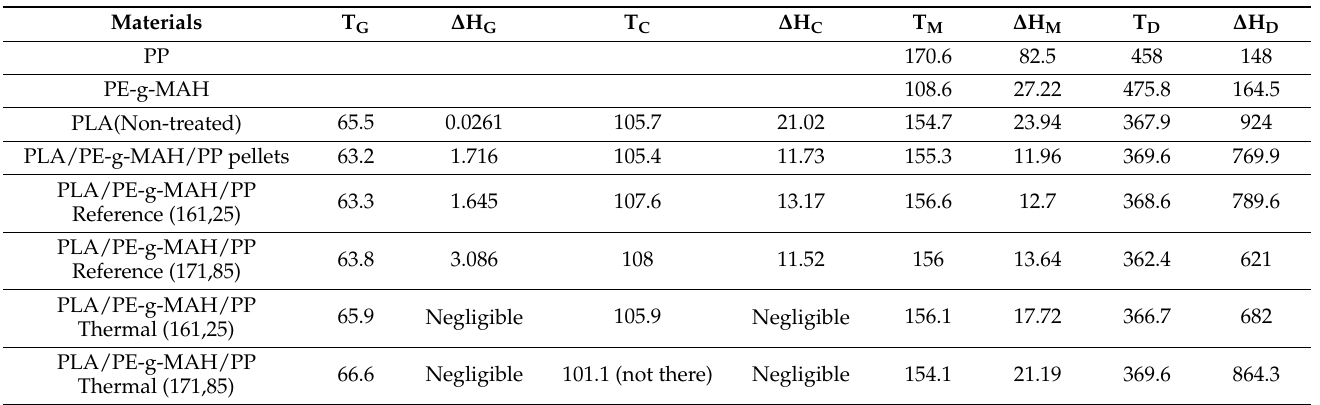
Table 3. DSC analysis for effects of blending, 3D printing, and thermal